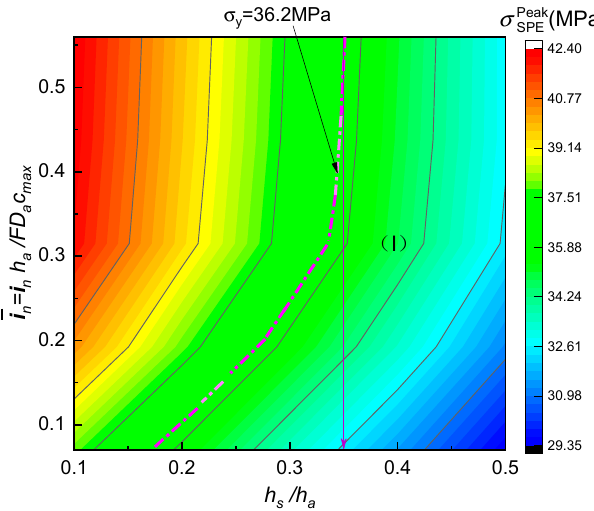
Figure 11. Combined e ff ect of dimensionless surface current density ( i n ) and thickness ratio ( h s / h a ) on the peak tensile stress of two-years-aged SPE film.